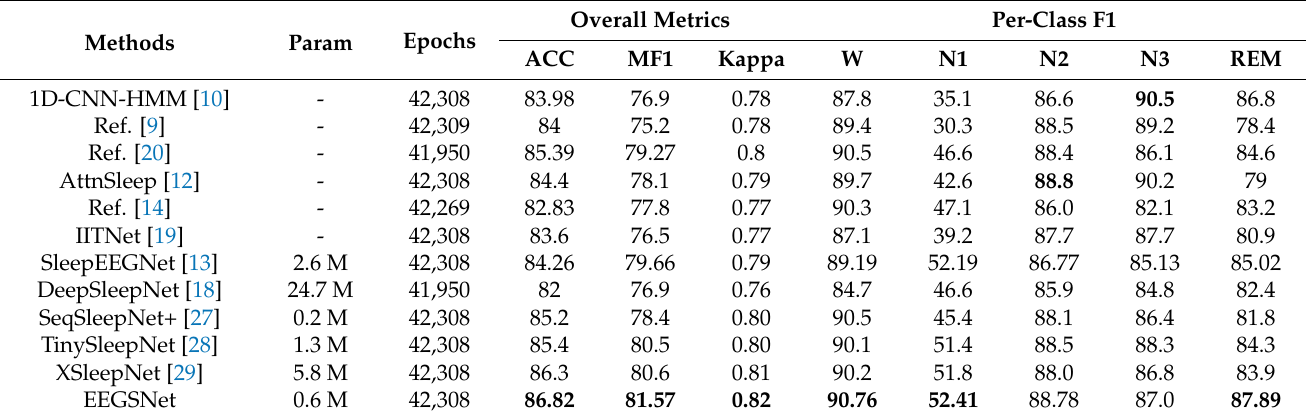
Table 8. Comparison of performance metrics obtained by our method with other state-of-the-art algorithms on